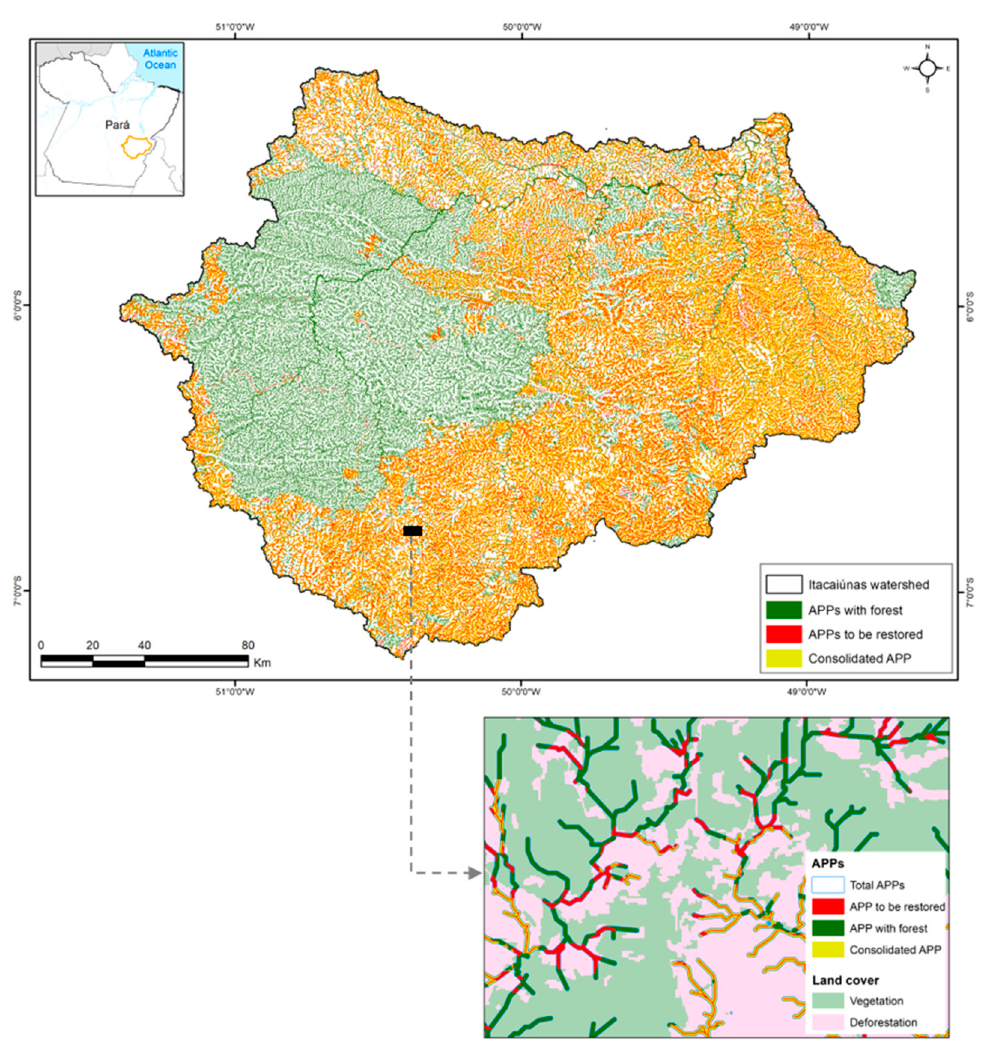
Figure 9. Distribution of permanent preservation areas, as defined by Brazilian environmental law (Law no. 12651, 25 March 2012), across the Itacaiúnas watershed.